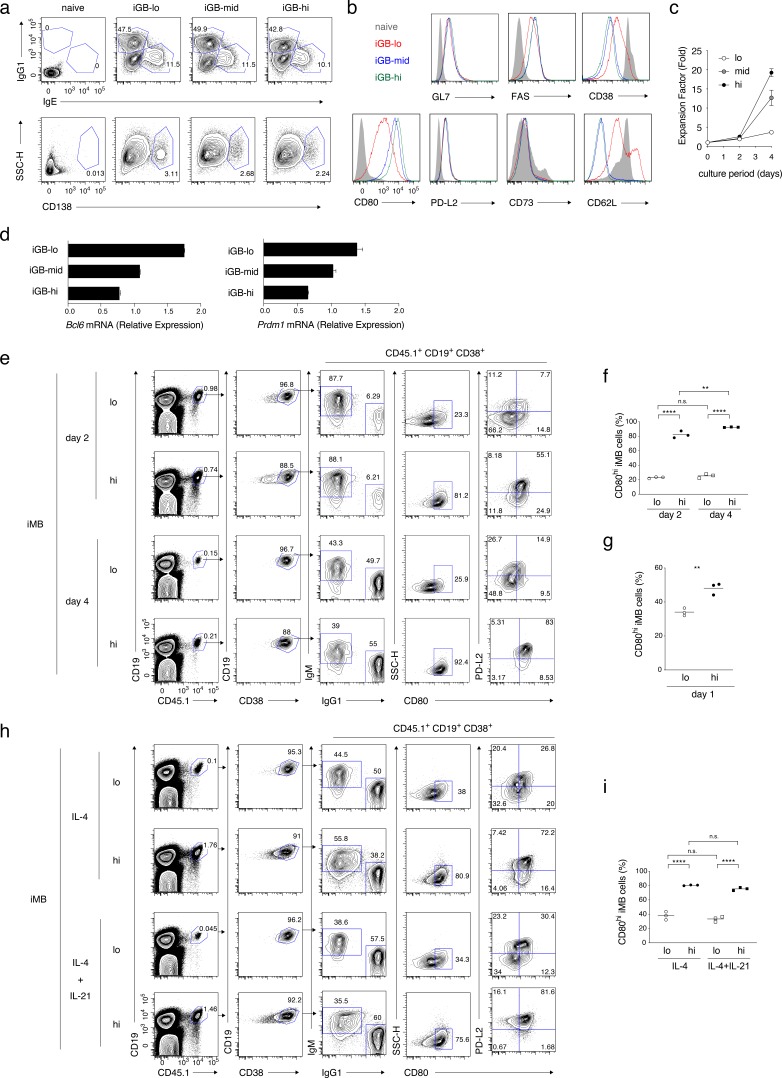
Cellular phenotype, proliferation capacity, gene expression, and differentiation fate of each type of iGB cells.(a) The frequencies of IgG1+ vs IgE+ cells, or of CD138+ cells, in naïve and the indicated iGB cells on day 4 of culture. (b) The expression of the indicated protein on naïve and the indicated iGB cells. (c) Cumulative fold increasein the numbers of B cells cultured on the feeder layer of each 40LB subline (hi, mid, lo). (d) qRT-PCR analysis of the expression of Bcl6 and Prdm1 mRNAs in the indicated iGB cells (mean + s.d. of triplicates). (e, f) iGB-lo and iGB-hi cells on day 2 or day 4 of the culture were transferred into irradiated B6 mice to generate iMB cells. Two weeks later, spleen cells of the recipient mice were analyzed by FCM. (e) A representative FCM data showing the gating strategy. (f) The frequency (%) of CD80hi cells in iMB cells (CD19+ CD45.1+ CD38+) derived from the iGB-lo and iGB-hi cells on day 2 or day 4 (n = 3). (g) The frequency (%) of CD80hi cells in iMB cells derived from iGB cells cultured for 1 day on 40LB-lo or 40LB-hi feeder cells (n = 3). (h, i) iMB cells were generated from iGB-lo and iGB-hi cells that were cultured with IL-4 and IL-21, or IL-4 alone, for 4 days. (h) Representative FCM data showing the gating strategy. (i) The frequency (%) of CD80hi cells among the iMB cells derived from the iGB cells cultured in the indicated condition.